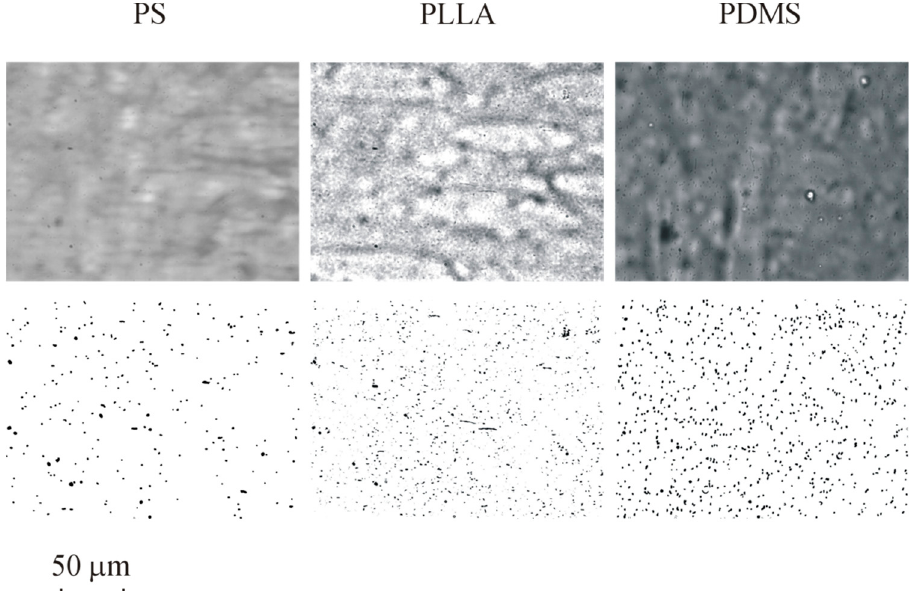
Figure 4. Images for adhesion in different materials for t = 1800 s: PS, PLLA and PDMS. Top row is before and bottom row after image processing. Results obtained for nominal wall shear stress of 0.02 Pa.